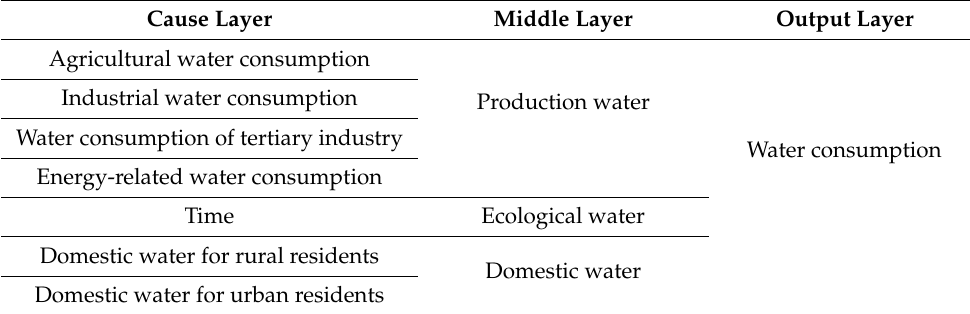
Table 3. Cause hierarchy for the water consumption.